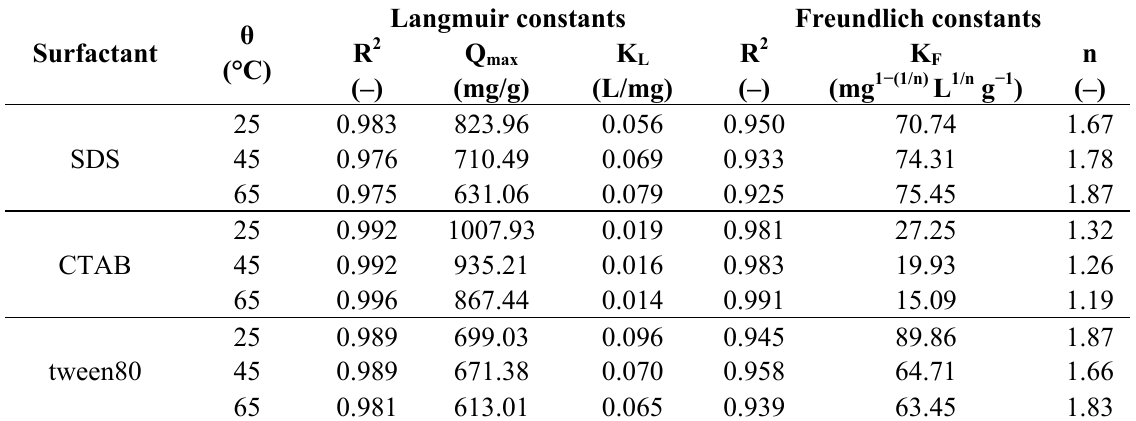
Table 2. Equilibrium parameters for adsorption of surfactants on akaganeite.